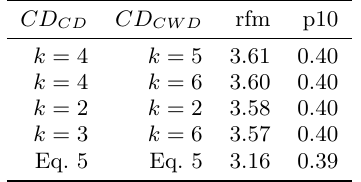
Table 4: Evaluation of contact duration functions